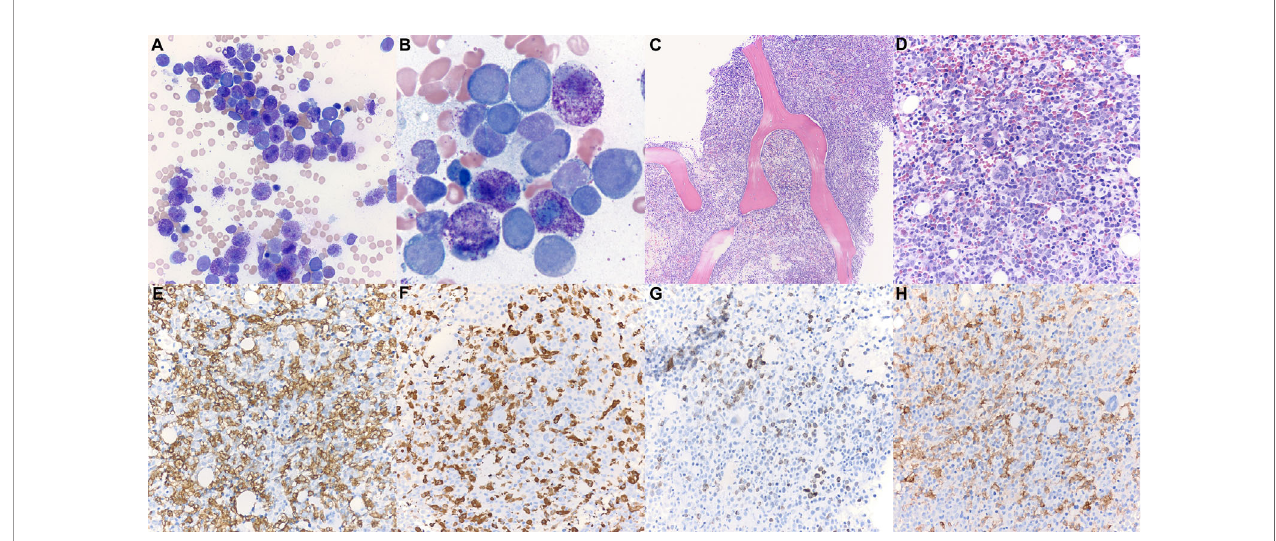
FIGURE 1 | Patient 1 bone marrow aspirate and trephine biopsy. (A, B) Bone marrow aspirate smear (Wright-Giemsa, ×400, ×1,000) isnotable for numerous mast cells intermixedwithmyeloblasts. Degranulated mast cells are interspersed throughout the bone marrow aspirate smear. (C) The bone marrow biopsy (H&E, ×100) demonstrates hypercellular marrow for age (90% cellularity). (D) Approximately50% of the cellularity is composedof mast cells with oval nuclei,and hypogranulatedcytoplasm (H&E, ×400). Blast elements and other marrow elements are scattered throughout. (E) CD117 immunostain (×400) highlights abundant mast cells. (F) Mast cell tryptase immunostain (×400). (G) CD34 immunostain (×400) highlights blast elements, comprising >20% of non-mast cell cellularity. (H) CD25 immunostain(×400) is positive inthe neoplastic mast